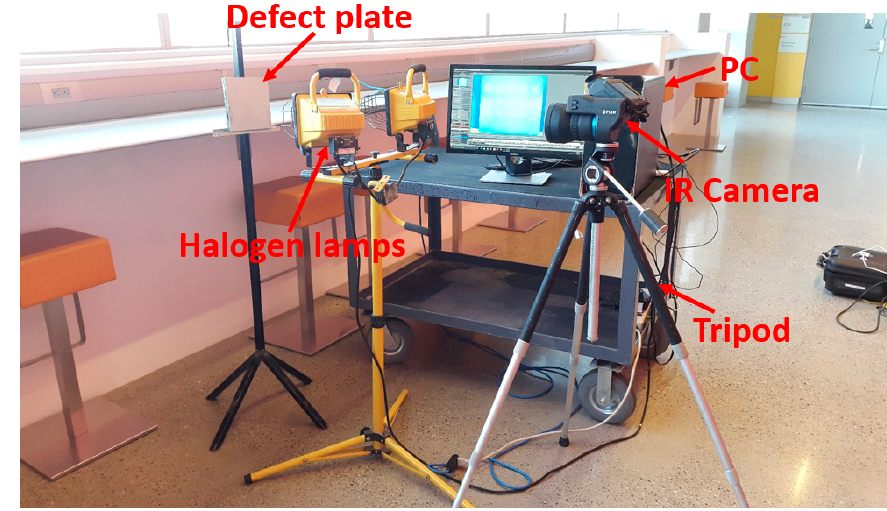
Figure 4. Step heating thermography experiment.